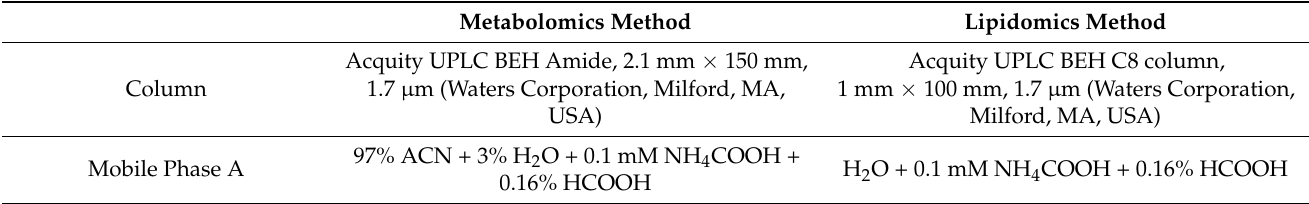
Table 1. LC-MS/MS Parameters used for the Metabolomics and Lipidomics